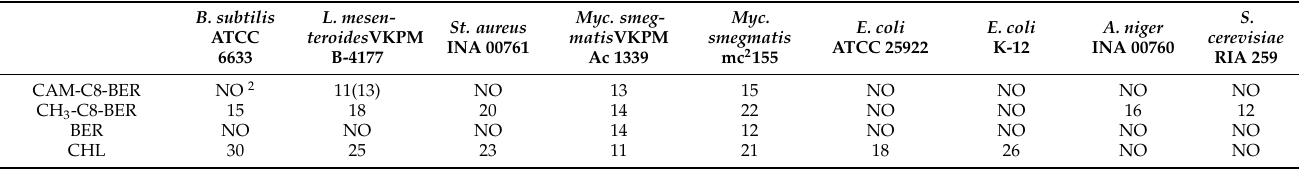
Table 2. Growth inhibition of various Gram-positive and Gram-negative strains of bacteria, as well as fungi and yeasts. The values of diameters of zones of growth inhibition of the studied strains (mm) are shown 1 . Antimicrobial activity was determined by the agar diffusion method. 100 µ L aliquots of the solutions (0.2 mg/mL) were loaded into wells 9 mm in diameter made in agar medium inoculated with test